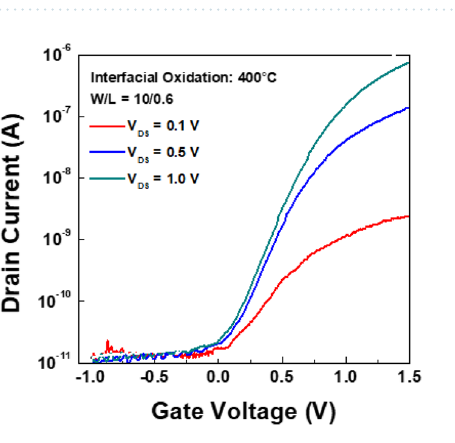
Figure 5. Transfer curves of the vertical TFT with Ta-IGZO interfacial oxidation for the gate